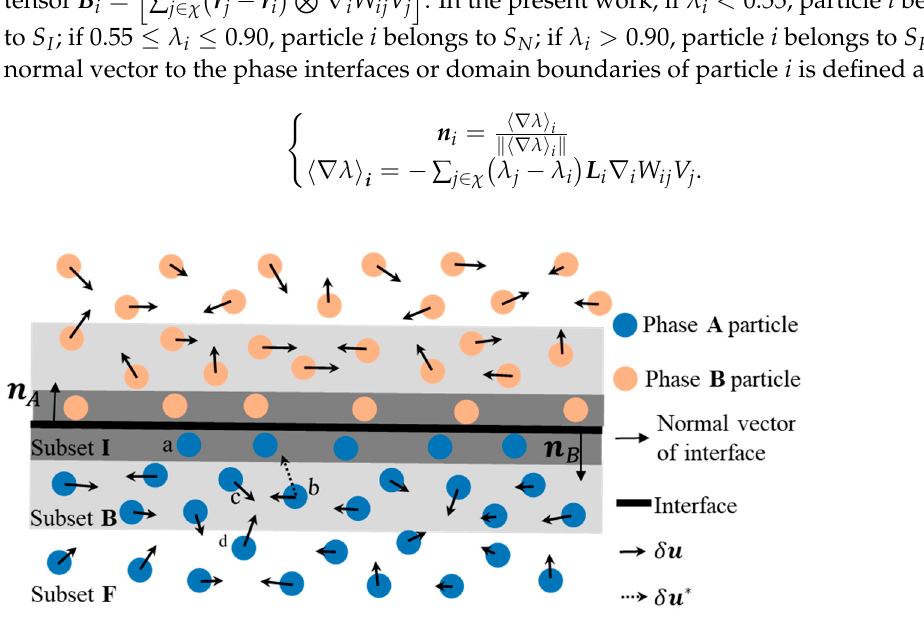
Figure 2. Shifting treatment near the phase interface.